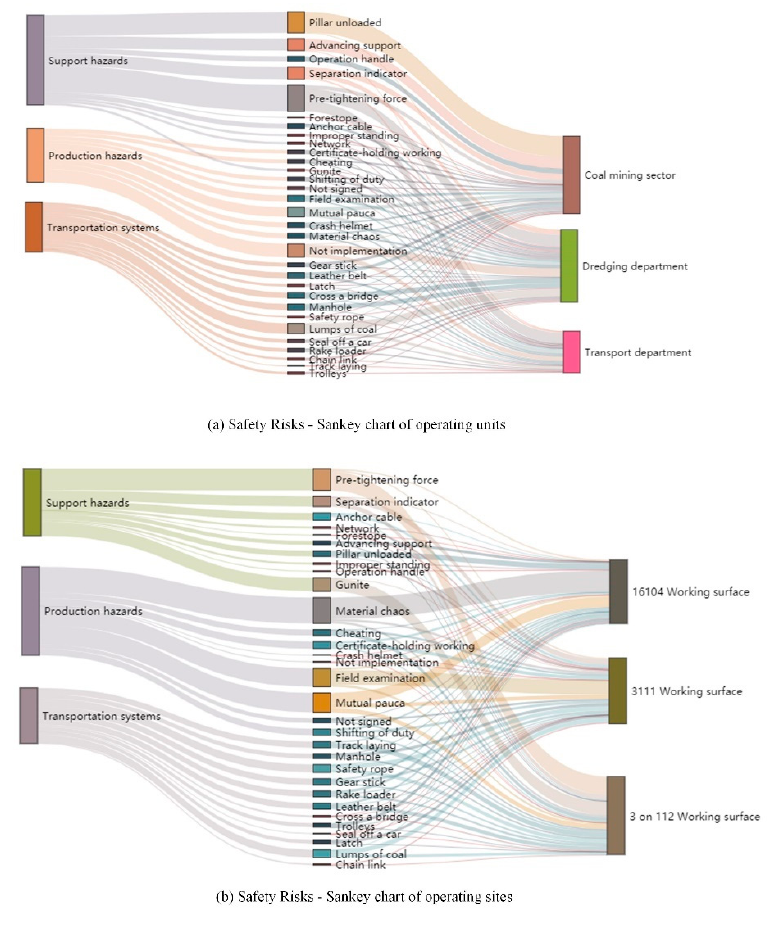
Figure 5. Sankey Chart of safety risks.